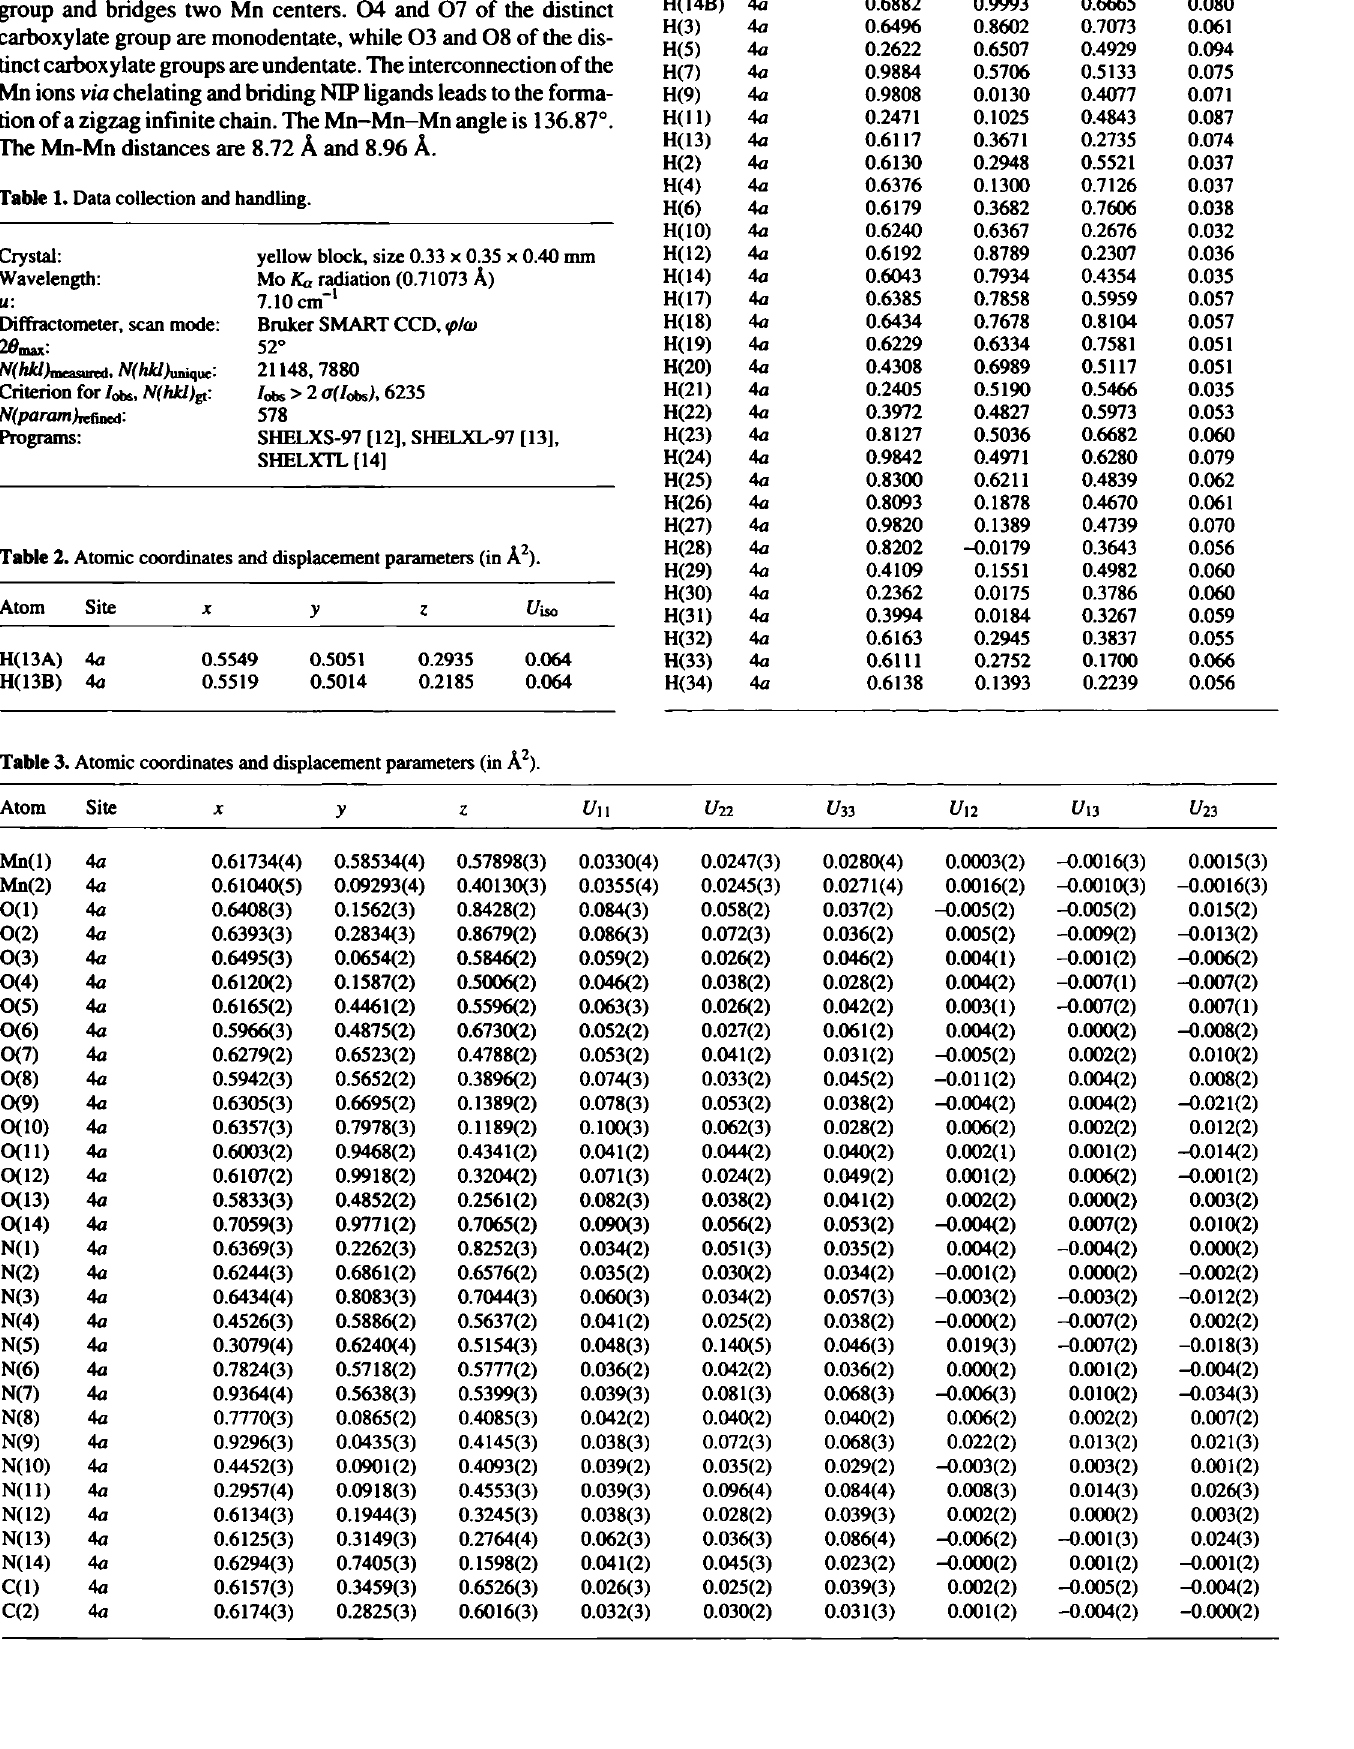
Table 3. Atomic coordinates and displacement parameters (in Â 2